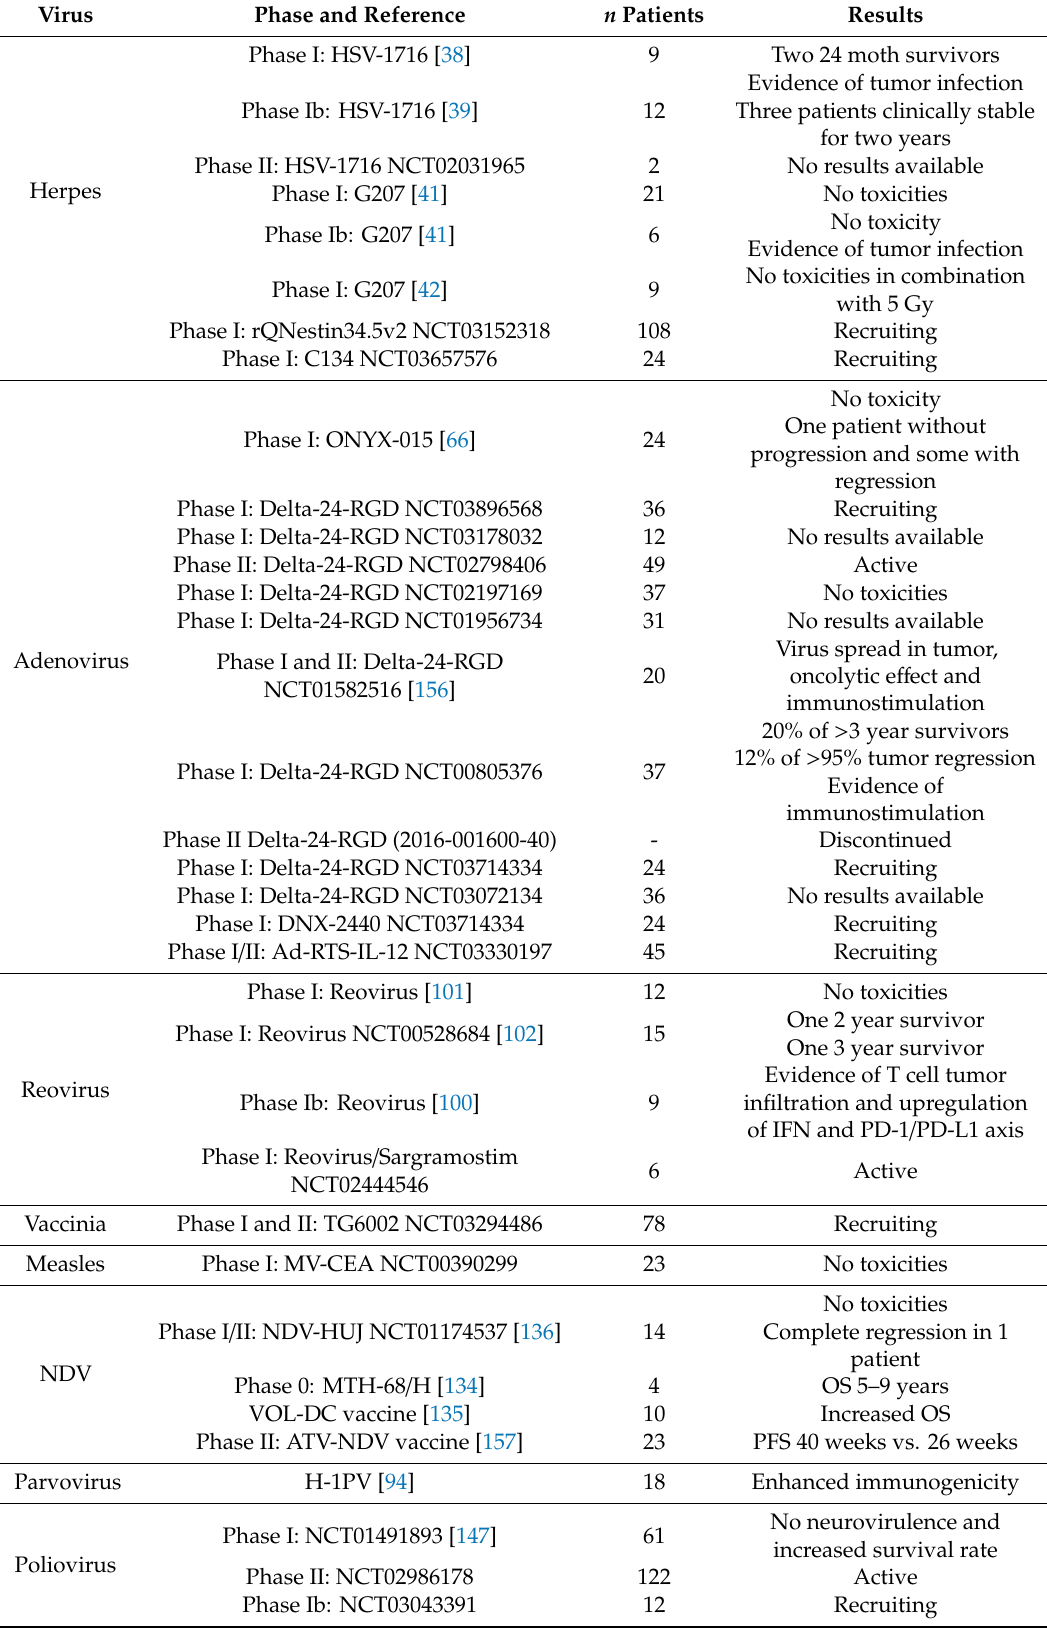
Table 3. Clinical trials of oncolytic viruses (OVs) for glioma